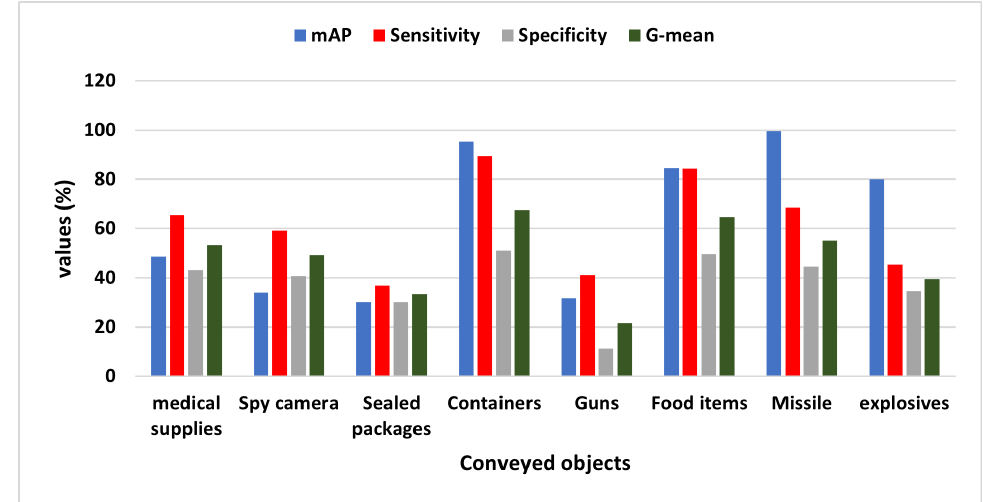
Figure 15. Graph showing the mAP, sensitivity, specificity, and G-mean values of ALIEN in identify- ing different conveyed objects by the